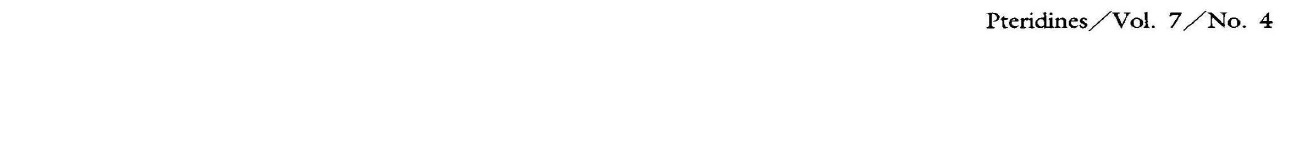
its efflux because the incorporated sepiapterin is converted to dihydrobiopterin and hence the equilibrium between sepiapterin inside and out side is continuously advanced by the influx. In contrast, tetrahydrobiopterin uptake may be en countered to the efflux of tetrahydrobiopterin. In the latter case, intracellular concentration may re flect downward to the efficiency of the biopterin uptake. Thus we established biopterin-depleting conditions. Cells were exposed to 5 mM DAHP overnight and the intracellular biopterin con- Pteridines/Vol. 7/No.